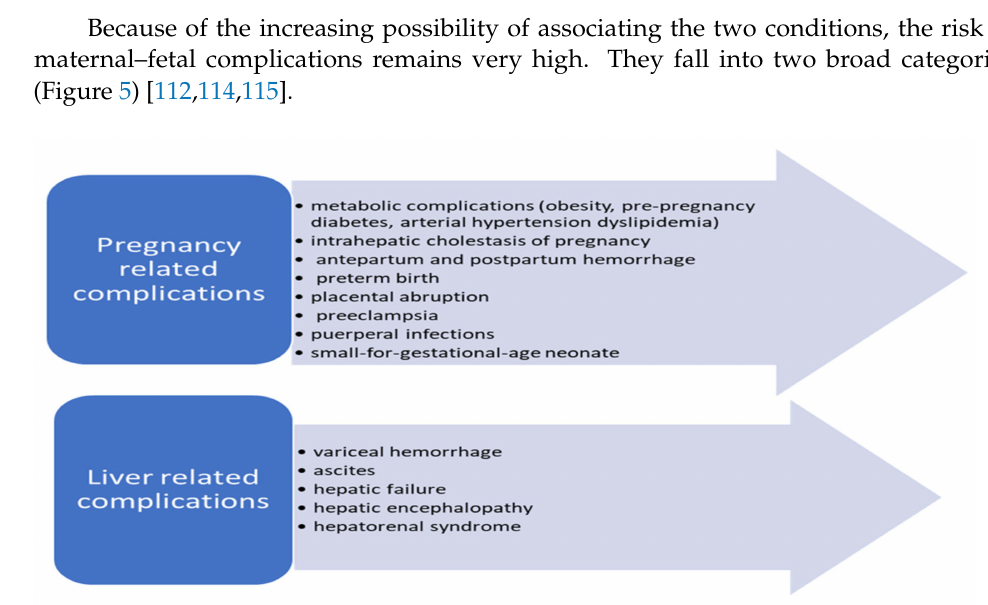
Figure 5. Complications that could develop in pregnant women secondary to liver